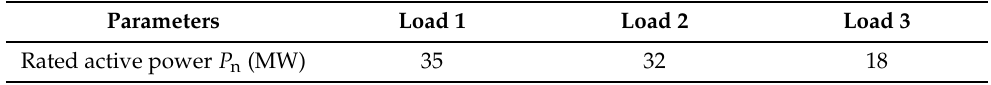
Table A6. The parameters of the constant loads, i.e., Load 1, Load 2, and Load